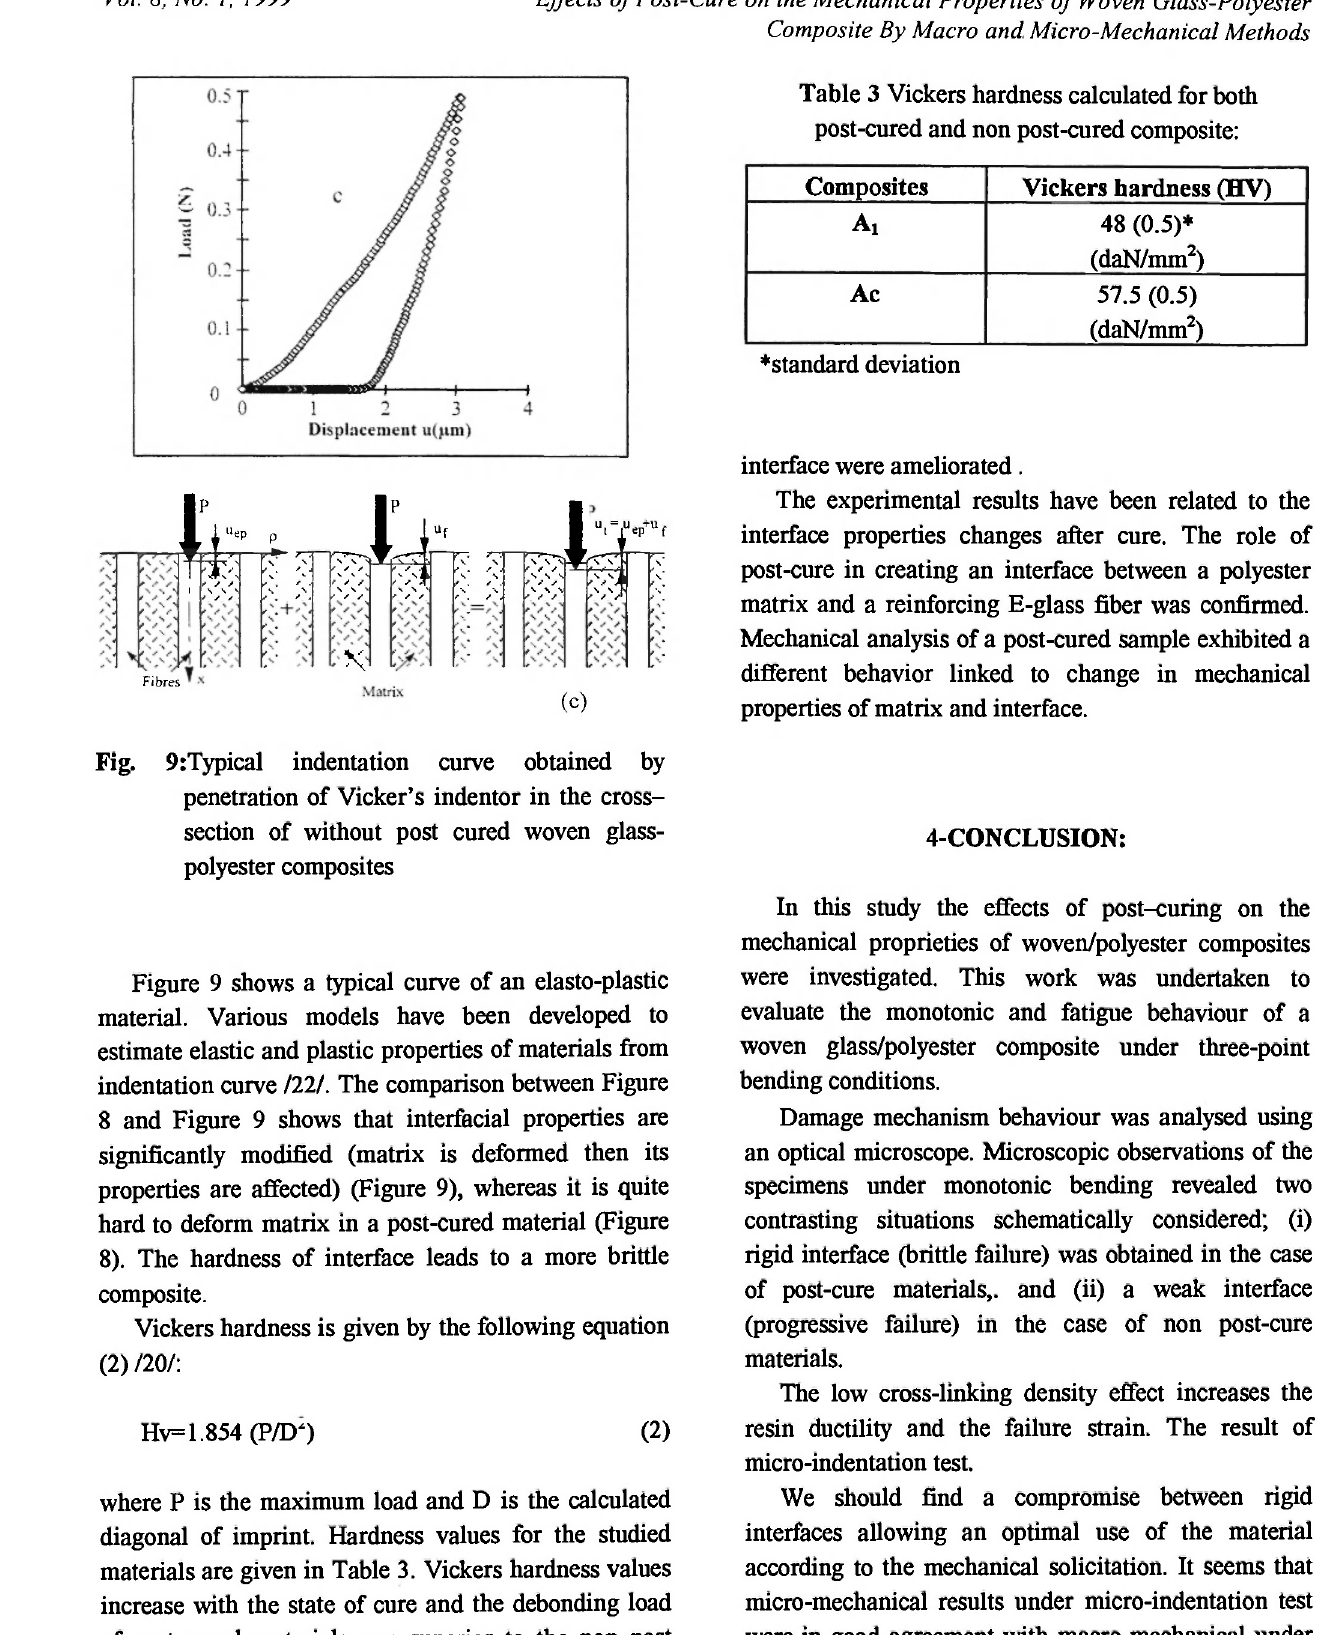
Fig. 9:Typical indentation curve obtained